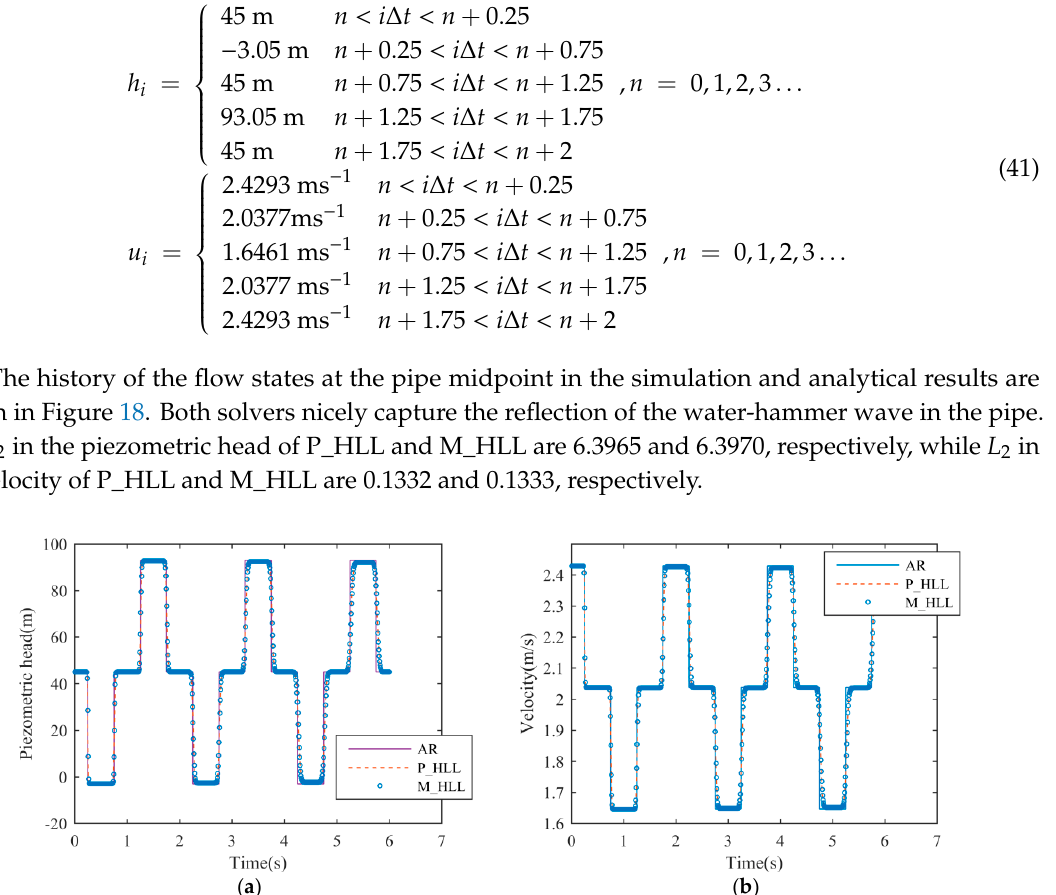
Figure 19. Locus of the flow states at the midpoint of pipe simulated by P_HLL ( P a = 1 and P b = 0.8) and the analytical result (AR): ( a ) piezometric head; ( b ) flow velocity.